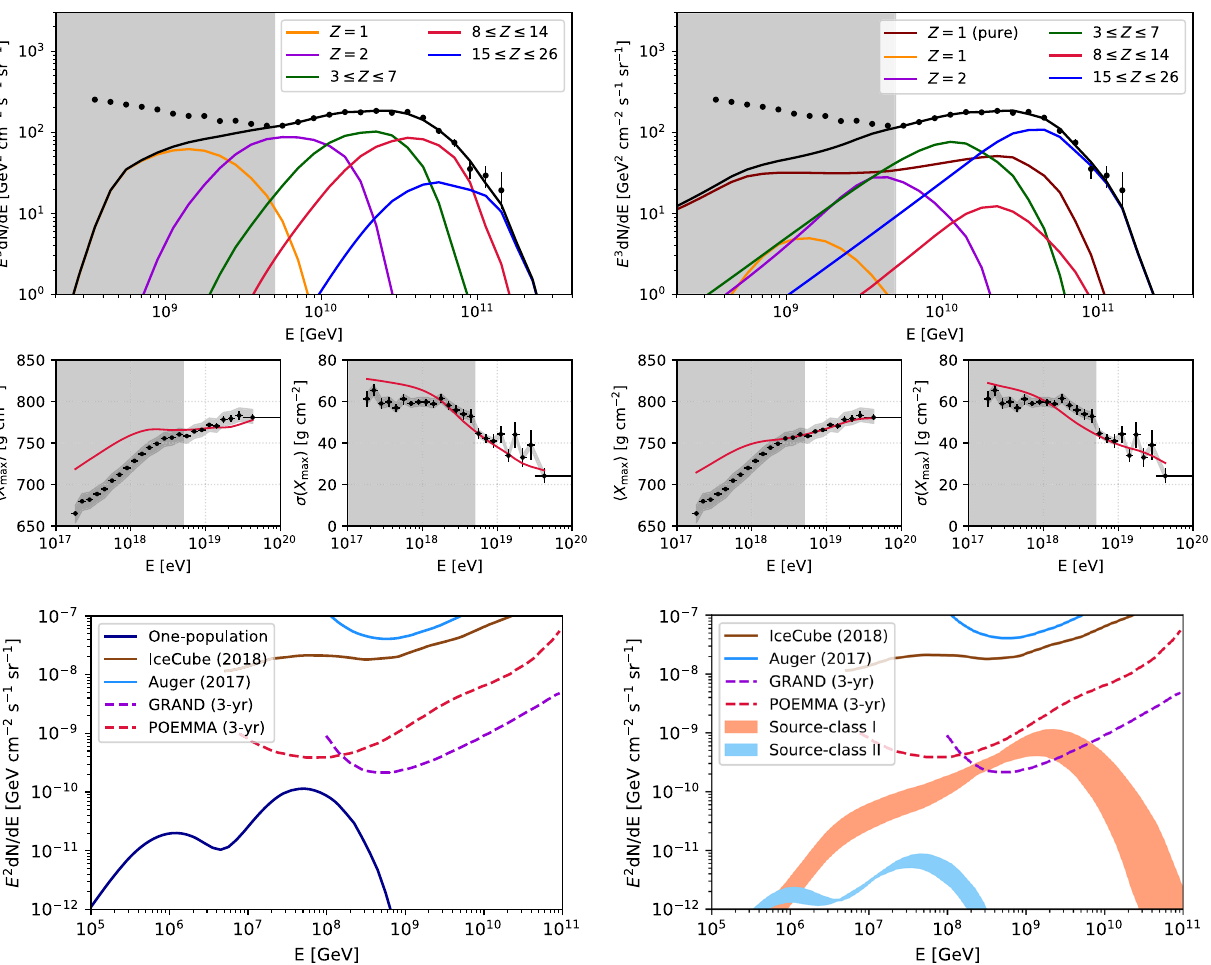
Fig. 4 Thefiguresinthetoppanelindicatesbest-fitspectrumandcom- position obtained by considering redshift evolution as a free parame- ter, for one-population ( left ) and two-population ( right ) model, respec- tively. The lower panel indicates the corresponding neutrino fluxes. The